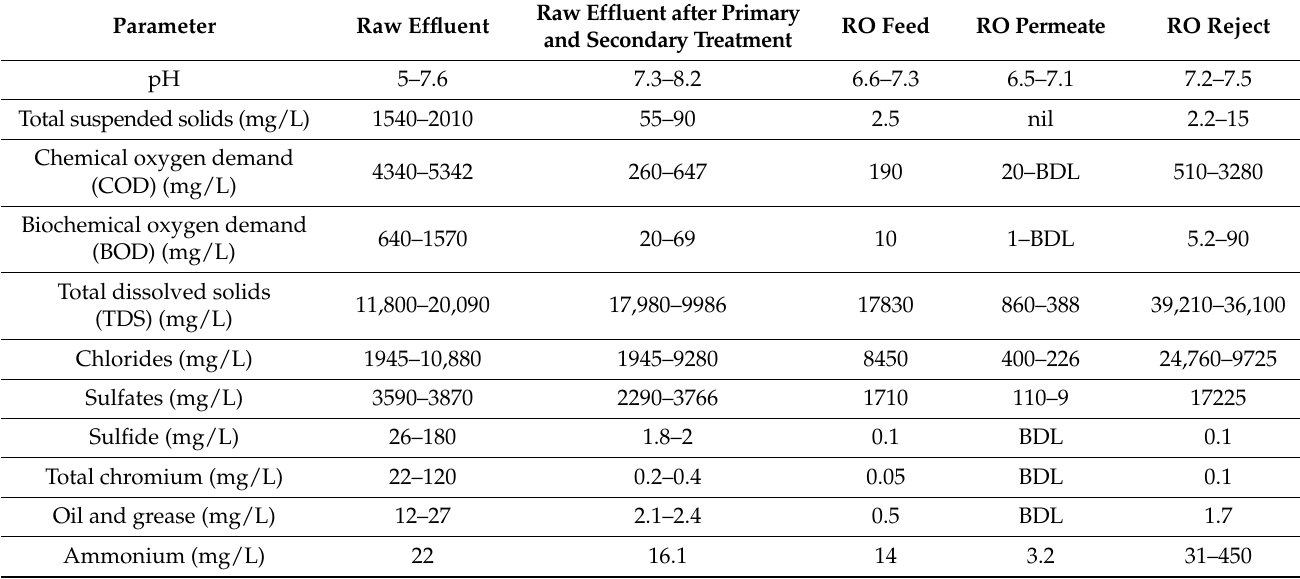
Table 2. Performance of RO technology in CETPs in Tamil Nadu,